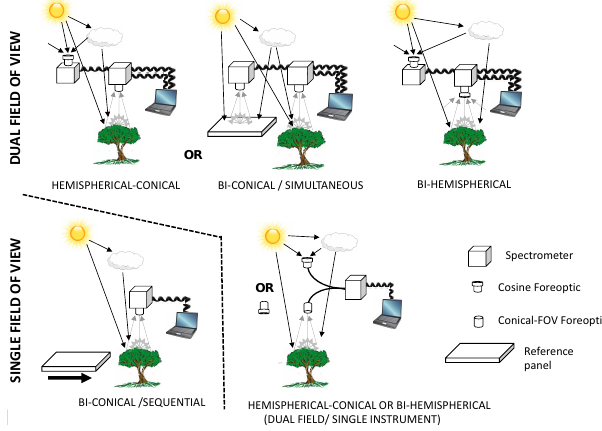
Figure 1. Main instrument configurations adopted for in situ spec- tral